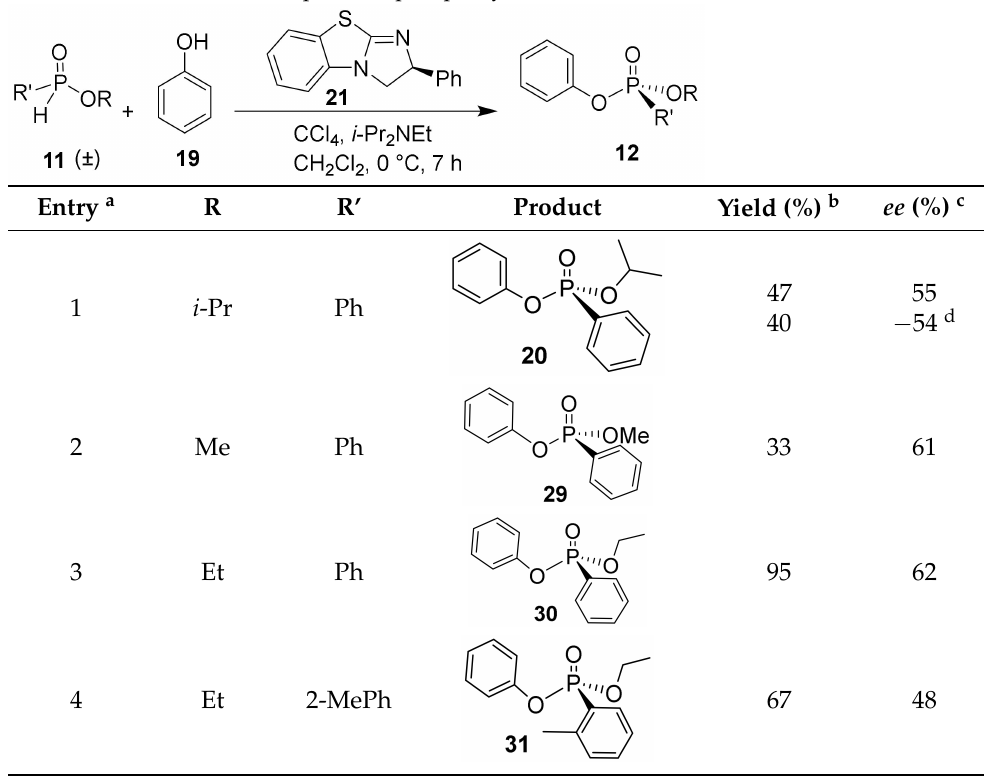
Table 3. Base effects of electrophilic on phosphorylation